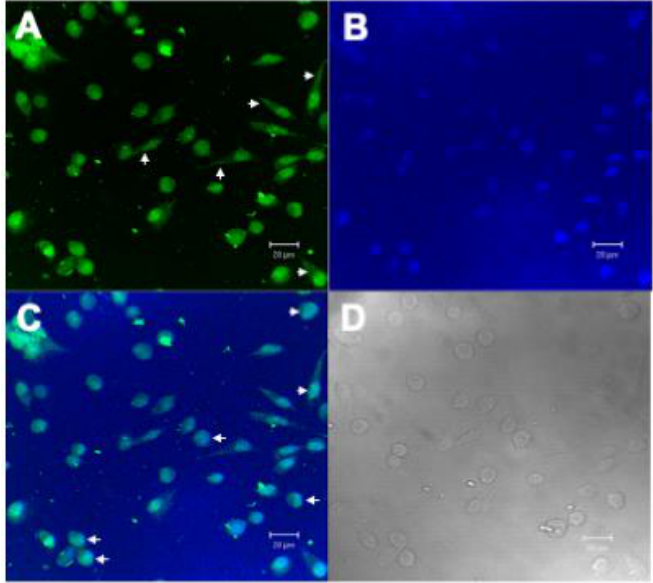
Figure 5. Confocal Microscopy Analysis of L929 with EcTI-AlexaFluor488. ( A ) L929 cells marked with EcTI conjugated with AlexaFluor 488 (green), showing cell surface localization (arrowheads), ( B ) L929 nuclei stained with 4′,6 -Diamidino-2-phenylindole dihydrochloride, DAPI (blue), ( C ) overlay of images with EcTI nuclear localization (arrowheads) in L929 cells and ( D ) differential interference contrast (DIC) microscopy of L292 cells. Scale bar: 20 µm.